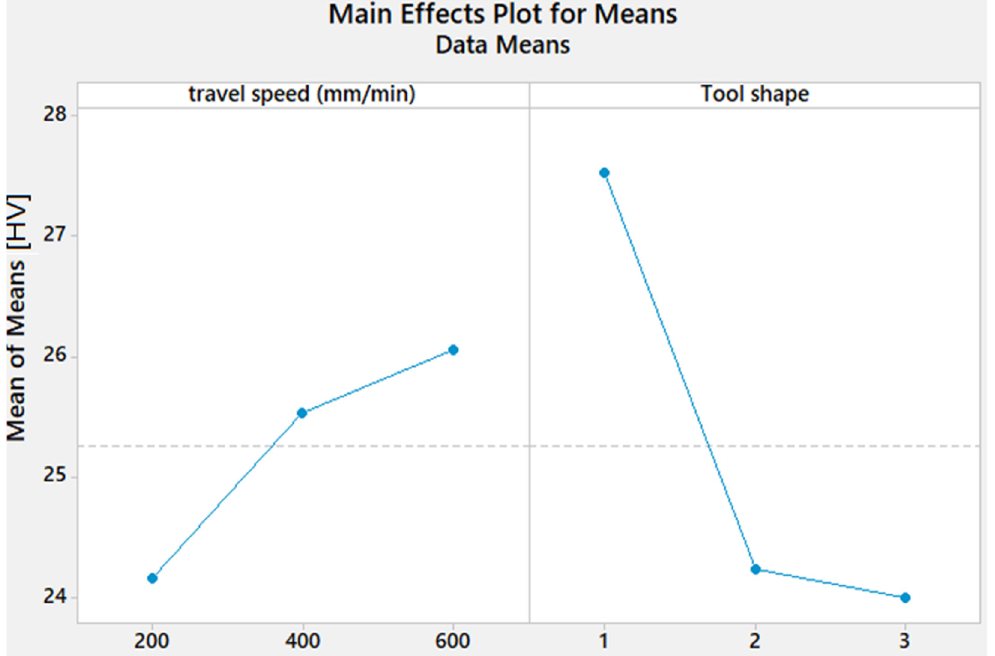
Figure 6. Effect of process parameters on the hardness of AA1050 thick lap joints.